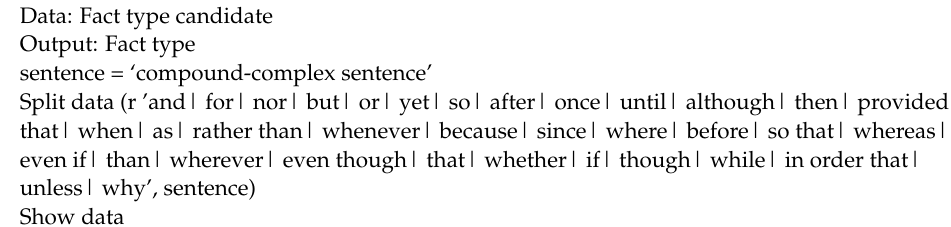
Algorithm 5. Fact type from compound-complex sentence